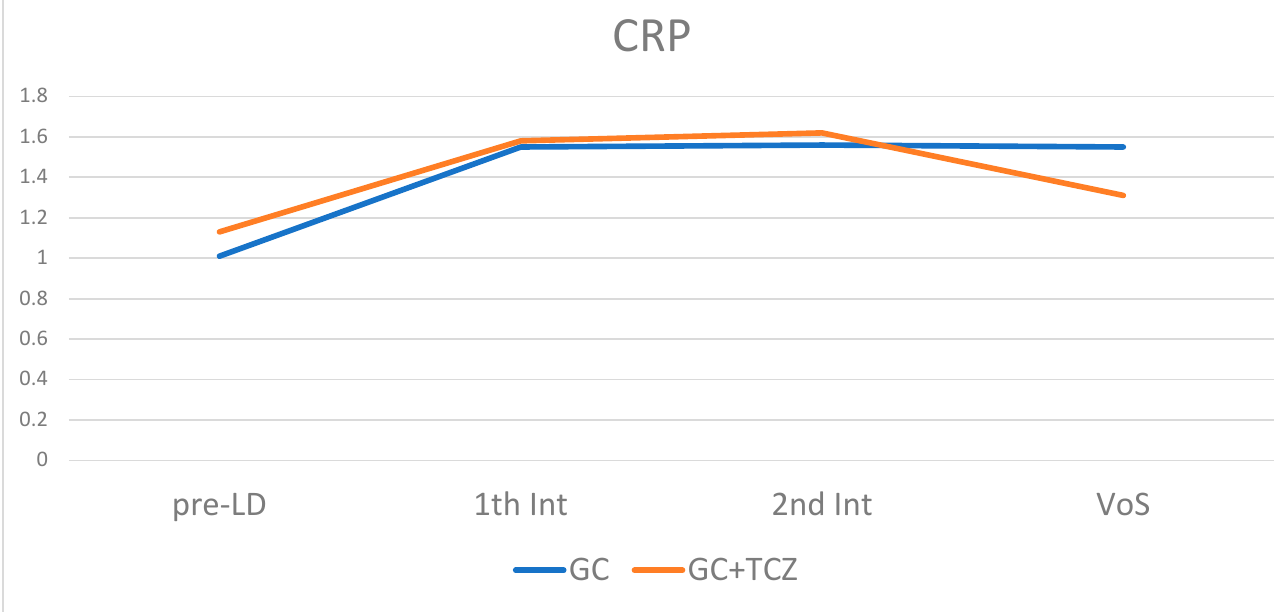
Figure 2. CPR trend during monitoring in the two different groups of patients treated with and without TCZ. CRP: C-reactive protein; GC: glucocorticoid; TCZ: tocilizumab; pre-LD: pre-lockdown visit; 1th Int: first interview; 2nd Int: second interview; VOS; visit on site.